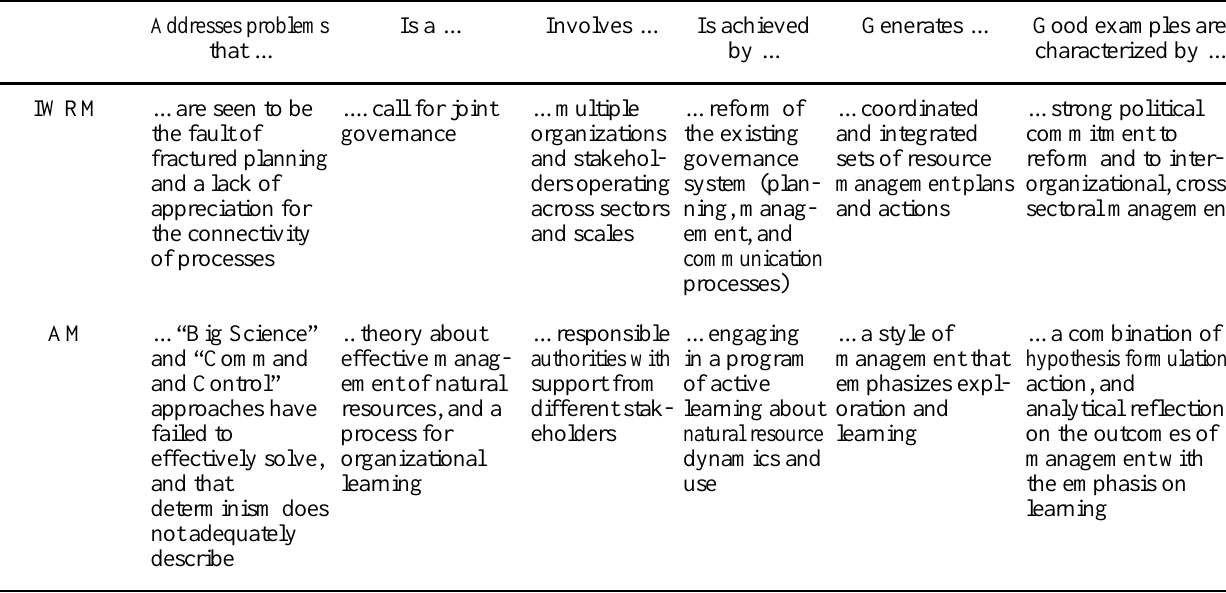
Addresses problems Is a ... Involves ... Is achieved that ...